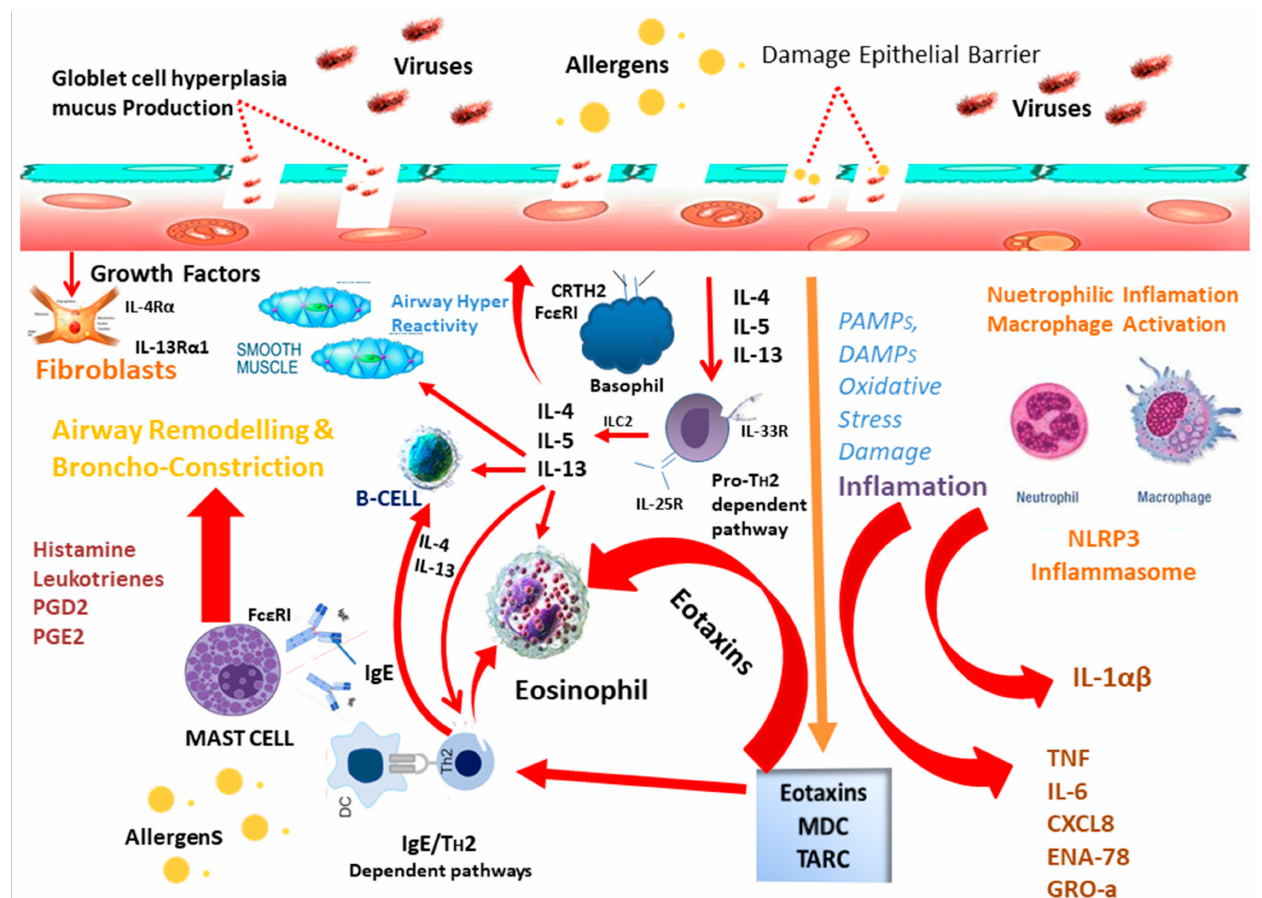
Figure 3. Overview of viral infection and synergistic or additive effects of allergen exposure causing IgE/T H 2 and proT H 2 inflammation. IL-25R: IL-25 receptor; GRO-a: melanoma growth stimulating activity-a; IL-13R: IL-13 receptor; IL-33R:IL-33 receptor; ENA-78: epithelial-derived neutrophil-activating protein 78; IL-4R: IL-4